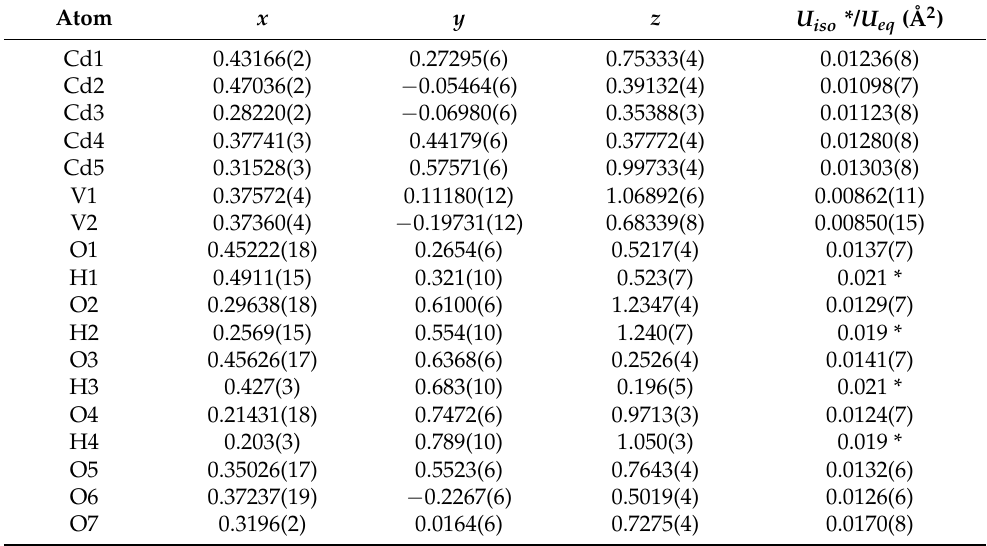
Table 2. Fractional atomic coordinates and equivalent isotropic displacement parameters for Cd 5 (VO 4 ) 2 (OH) 4